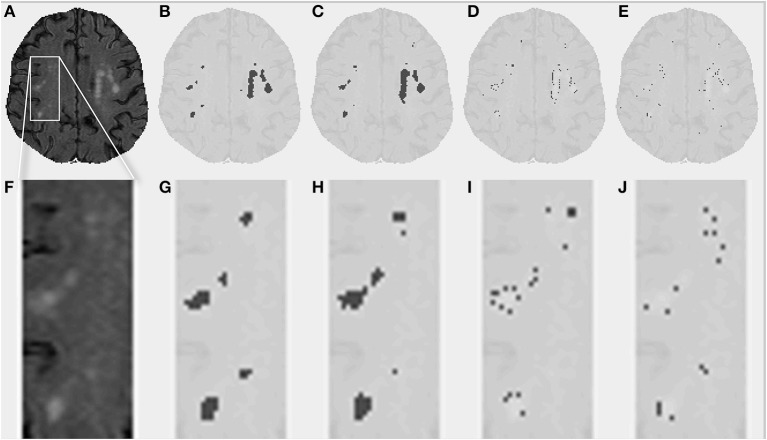
White matter lesions (WML) in the centrum semiovale. (A) FLAIR image for a given subject. (B) Conventionally estimated WML. (C–E) Estimated WML using the proposed segmentation algorithm, for full, intermediate, and small proportion of lesion. (F–J) Similar images for the zoomed portion depicted by the white box in (A).